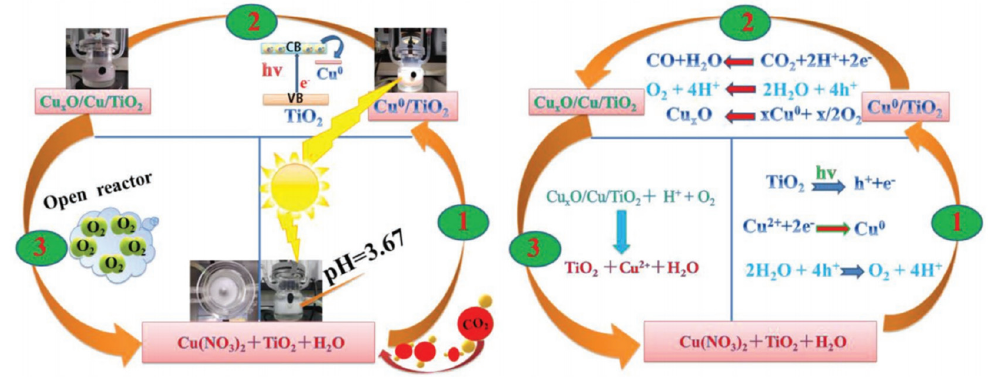
Figure 6. Mechanism of CO 2 reduction by Cu dispersed on TiO 2 nanoflakes [96].